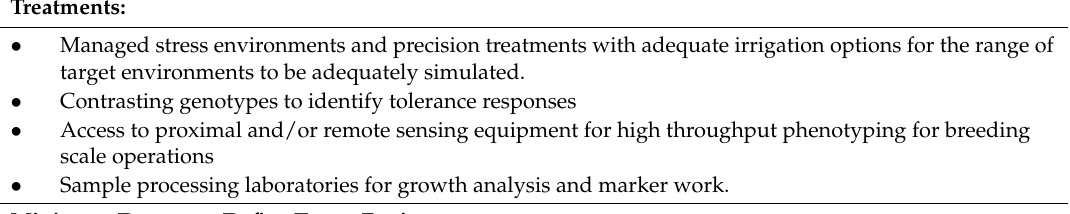
Table 2. Generic standards for field phenotyping platforms to support simulation modelling (adapted from